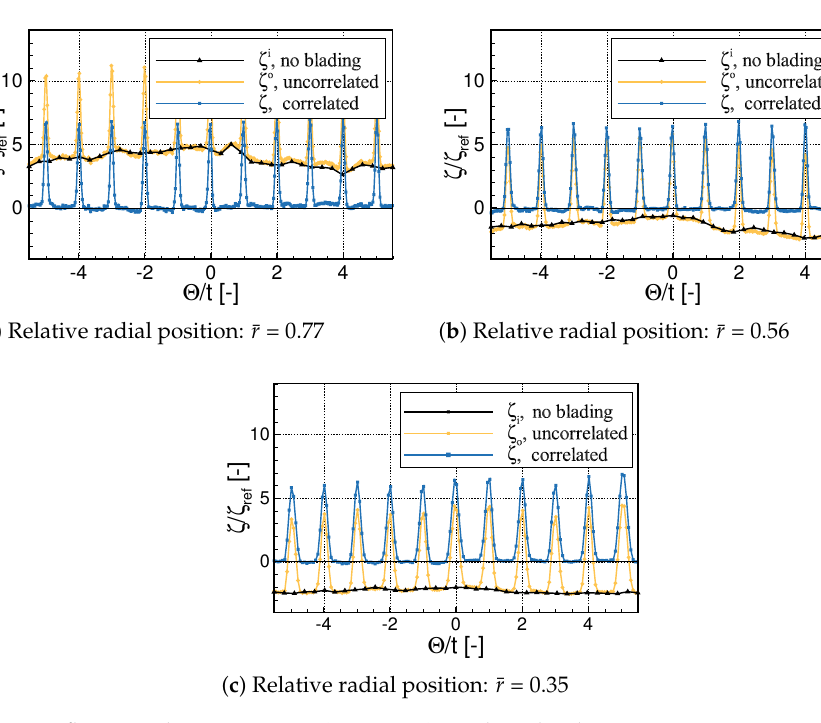
Figure 4. Inflow correlation at β S = 90 ◦ over 360 ◦ at selected radii. To emulate the angular flow deflection ∆Θ of the streamlines of i and o , a trigonometric approach based on the measured, circumferential flow angle β o between the VIGV and the measurement plane was chosen as a first approximation